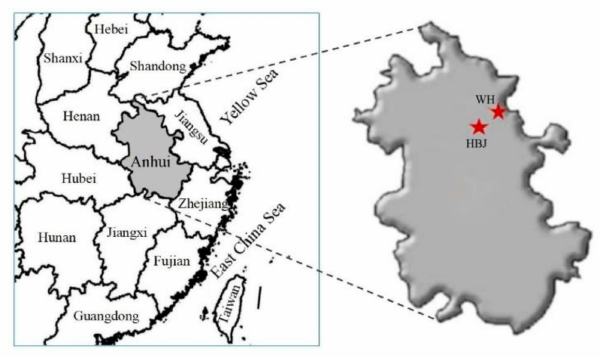
Figure 1. Location of sampling sites (red solid